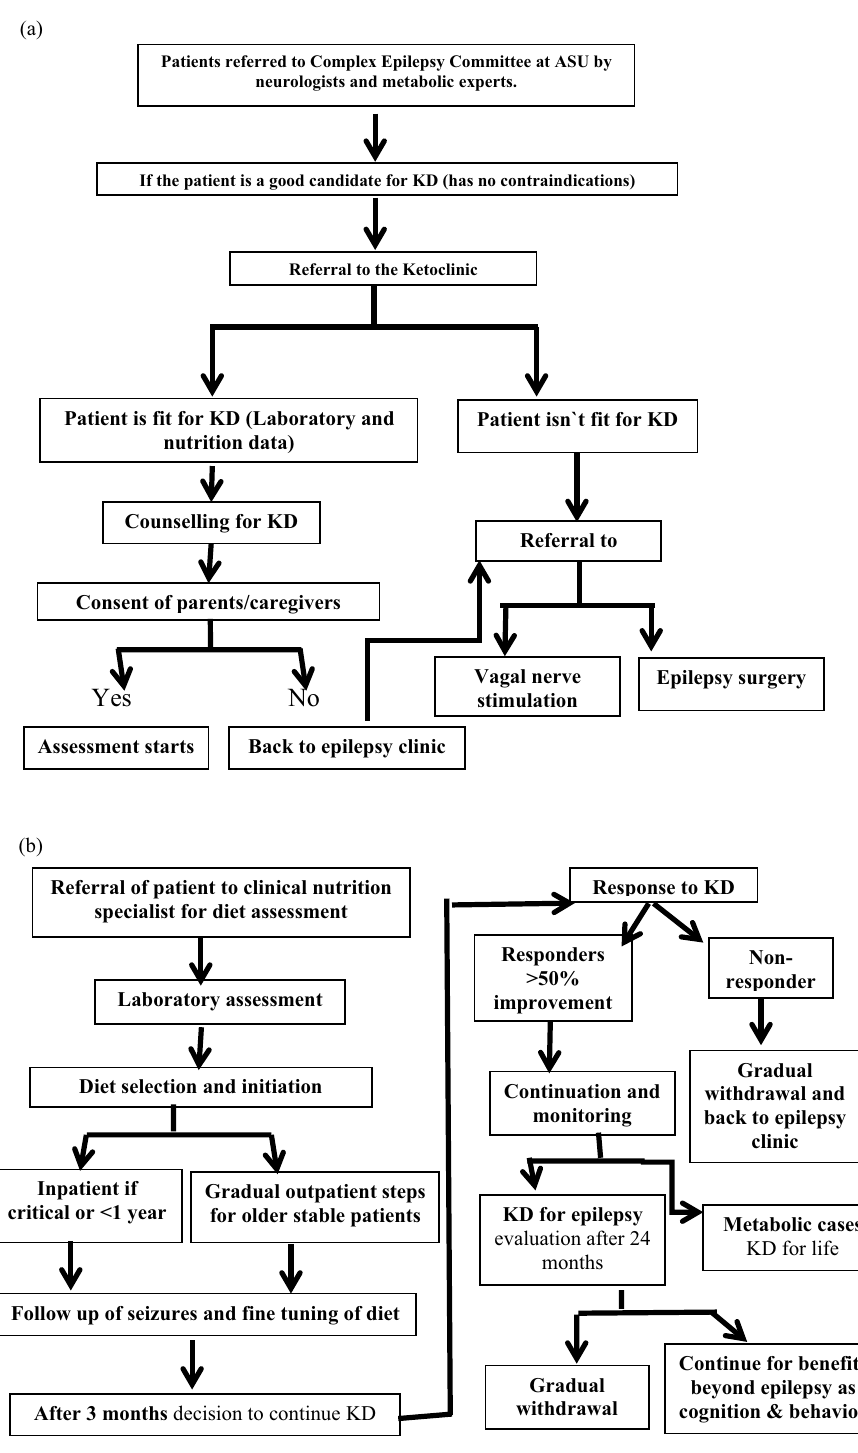
Figure 1. ( a , b ) Algorithm of the Ketoclinic protocol at the Children’s hospital Faculty of Medicine, Ain Shams University